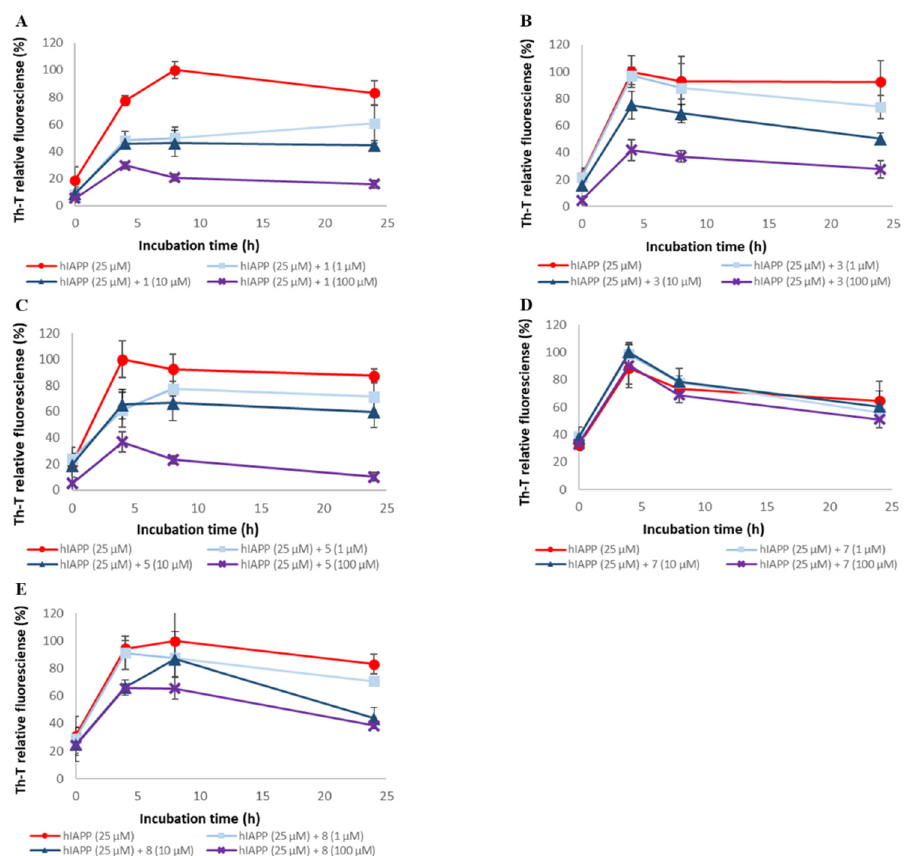
Figure 4. Efficacy of compounds 1 , 3 , 5 , 7 , and 8 against hIAPP aggregation. hIAPP (25 μ M) fibril formation was monitored by Th-T fluorescence with varying concentrations of these compounds.